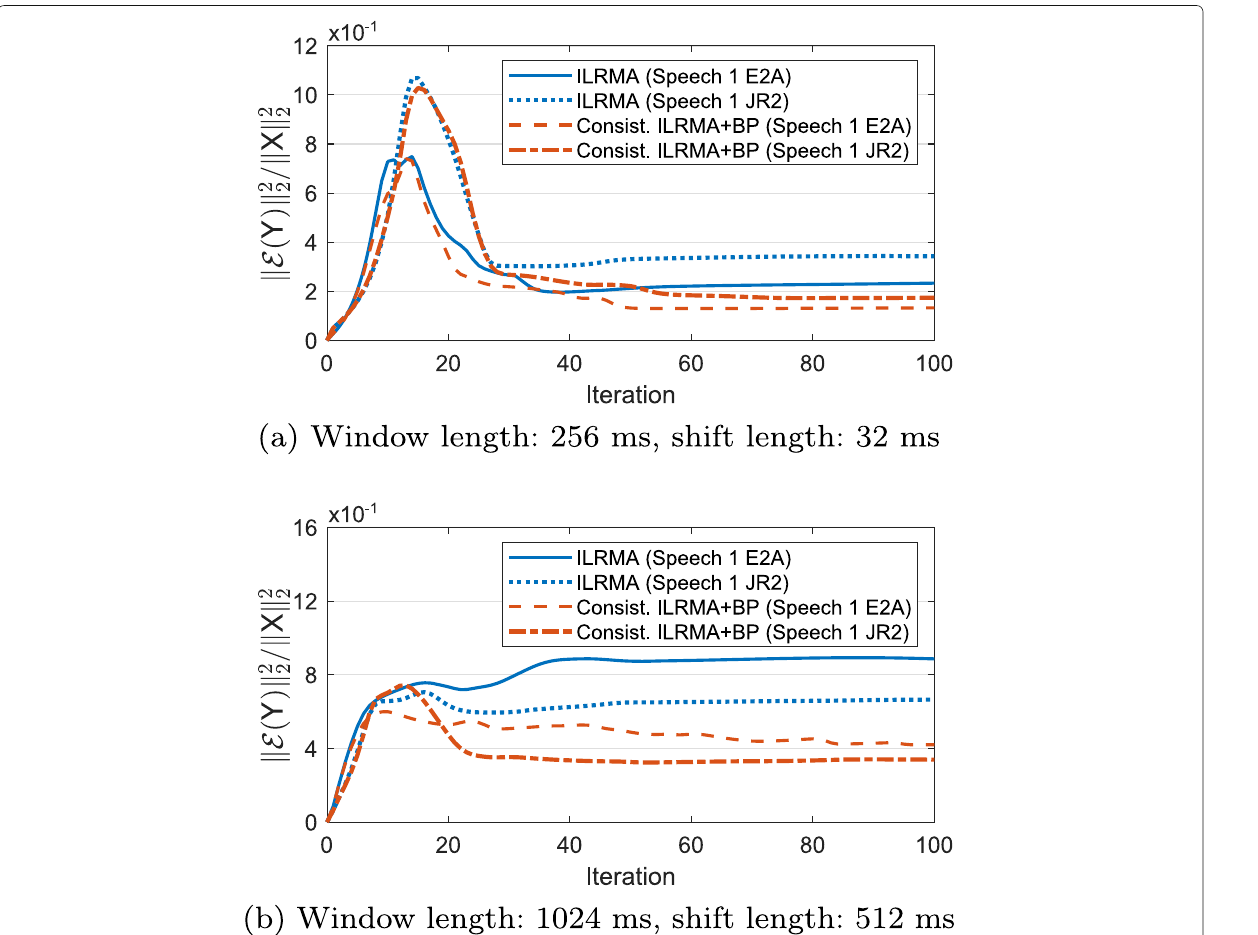
Fig. 7 Examples of normalized energy of inconsistent components ( (cid:7) E ( Y ) (cid:7) 2 2 / (cid:7) X (cid:7) 2 2 ) of ILRMA and Consistent ILRMA+BP for speech 1: a 256-ms-long window and 32-ms shifting and b 1024-ms-long window and 512-ms shifting, where X = [ X 1 , X 2 ],Y = [ Y 1 , Y 2 ], and E ( · ) is in (14)